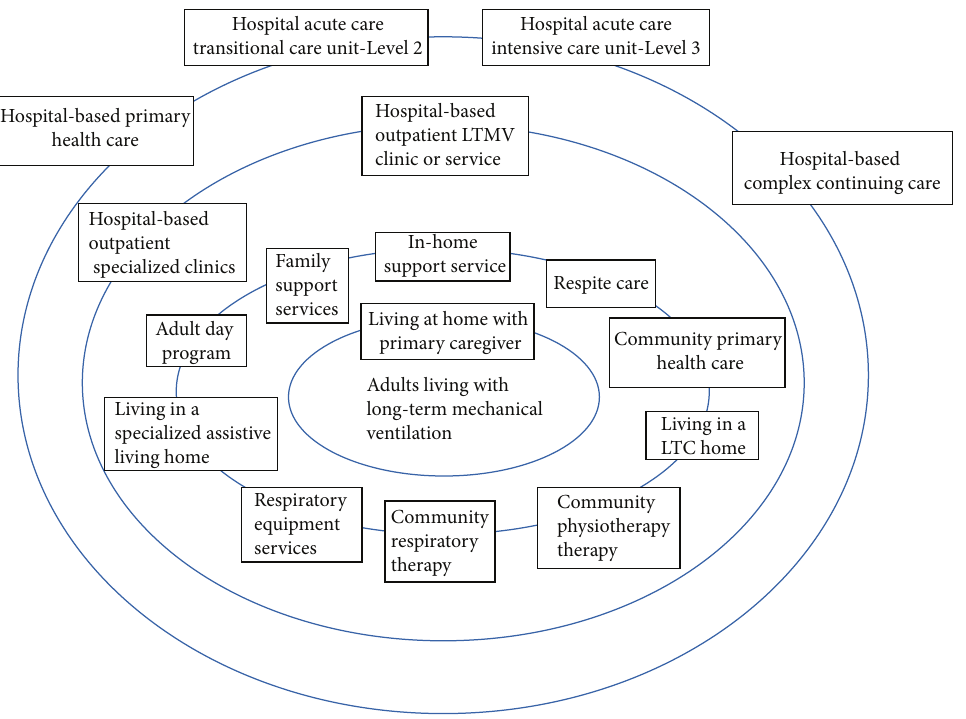
Figure 1: People, settings, and services for